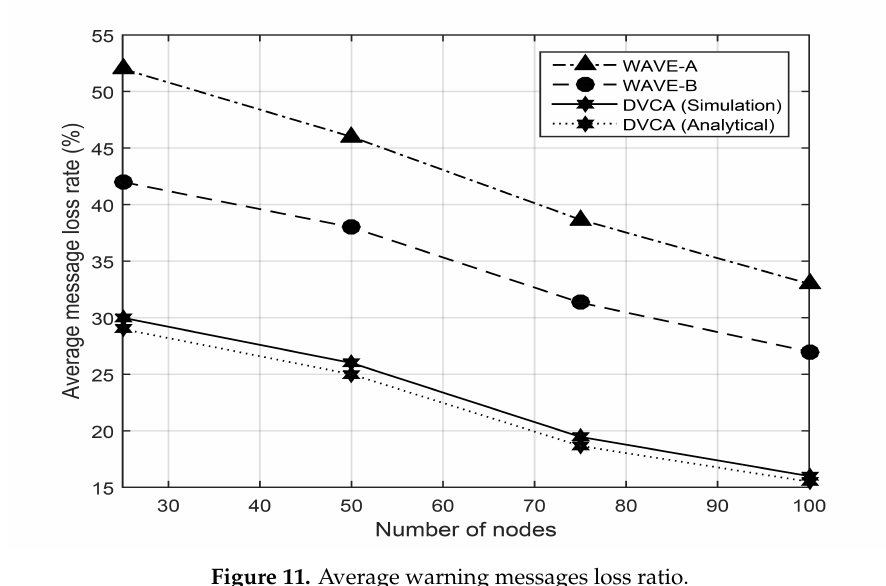
Figure 11. Average warning messages loss ratio.